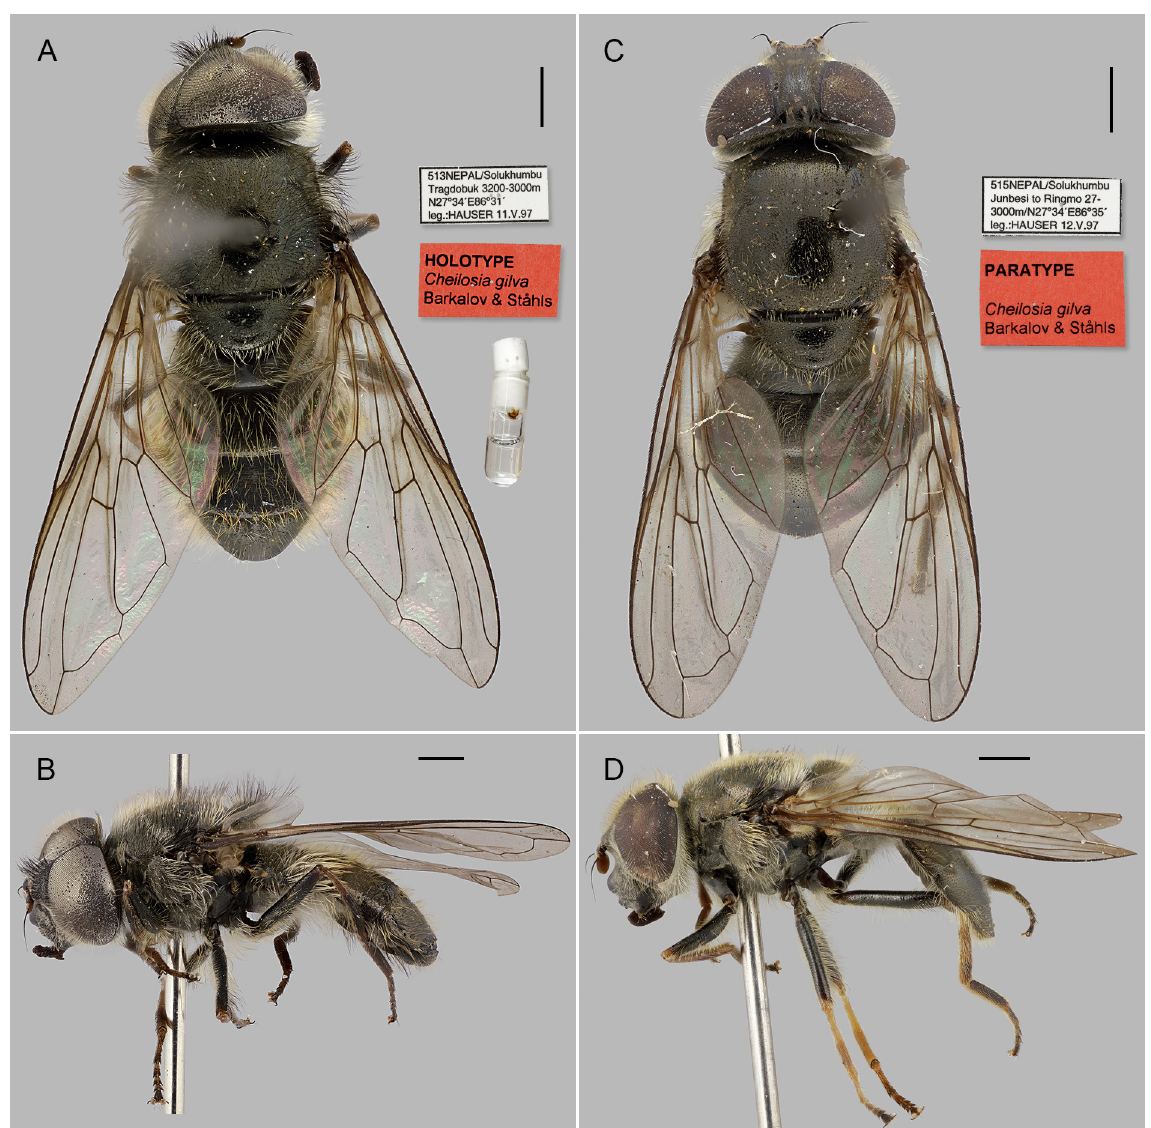
Fig. 26. Cheilosia ( Montanocheila ) gilva sp. nov. A–B . Holotype, ♂ (CSCA); dorsal and lateral views. C–D . Paratype, ♀ (CSCA); dorsal and lateral views. Photo: Pekka Malinen, FMNH Luomus. Scale bars = 1